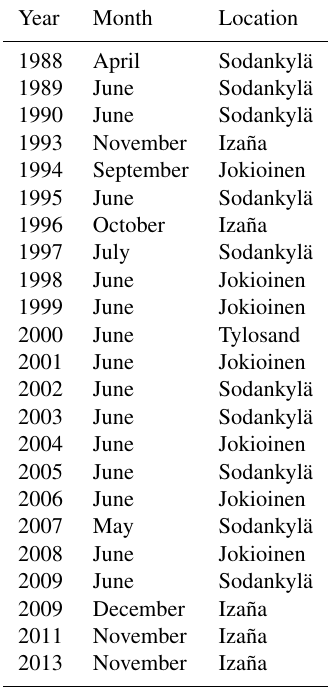
Table 1. Brewer no. 037 calibration history (partly adopted from IOS,